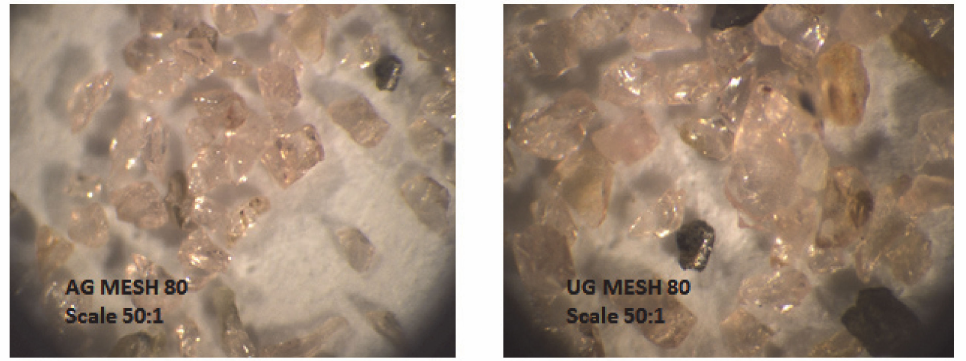
Figure 2. AG and UG samples with MESH 80 grain size.